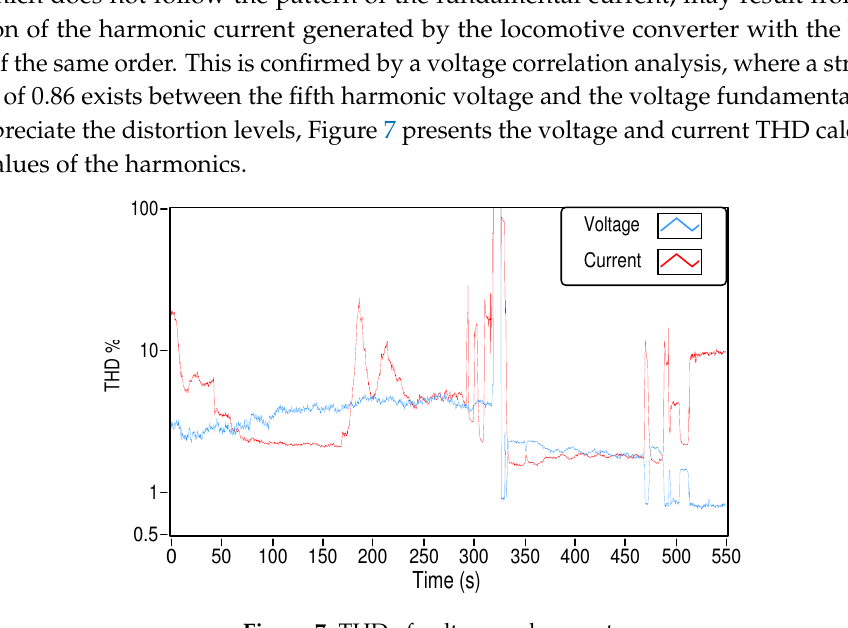
Figure 7. THD of voltage and